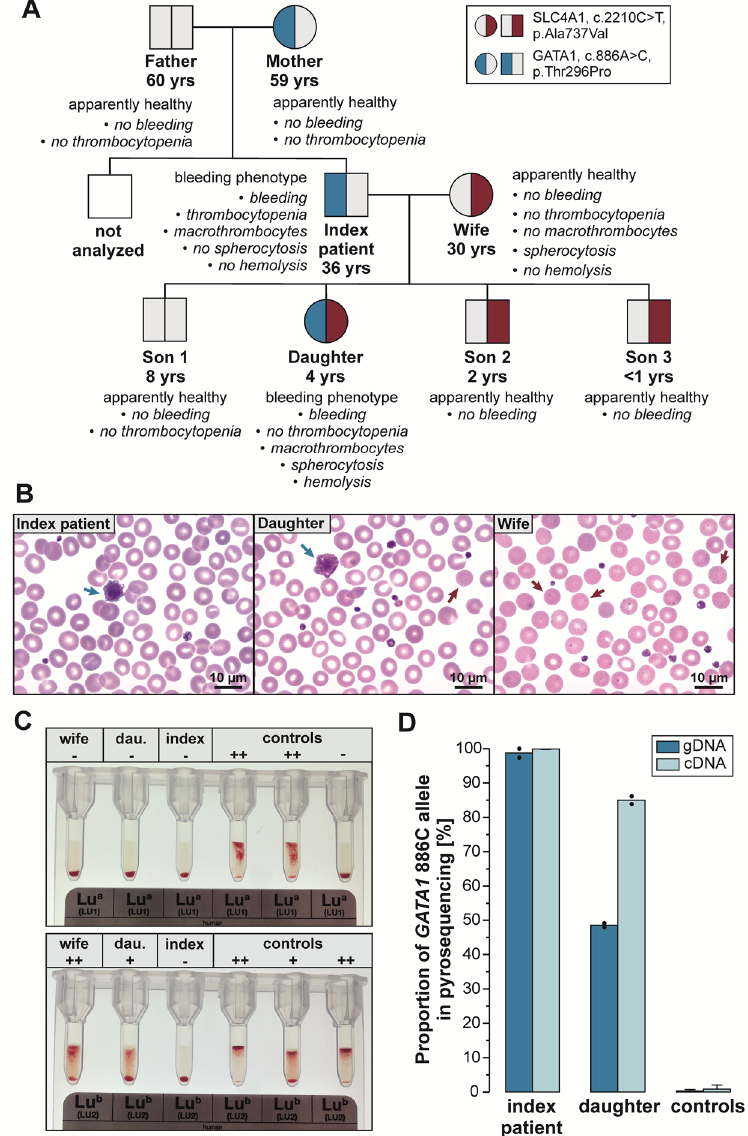
Figure 1. ( A ) Family pedigree with genotype for GATA1 : c.886A>C p.(Thr296Pro) and SLC4A1 : c.220C>T p.(Ala737Val), age at diagnosis, and individual phenotype. ( B ) Blood smear of index patient (left), his daughter (middle), and his wife (right), showing large platelets (blue arrows) and microspherocytes (exemplary, red arrows). Magnification: 100 × (oil). ( C ) Gel column agglutination assay for Lutheran blood group typing. All family members (index case, daughter (dau.), and wife) were Lu a negative (upper panel). The wife showed the highest amount of detectable Lu b (reaction strength 2+), the daughter was Lu b positive but weaker (reaction strength 1+), whereas the index patient was Lu b negative. ( D ) Analysis of X-chromosome inactivation via allele quantification of cDNA and gDNA using pyrosequencing and the pathogenic allele 886C ( GATA1 ). The index patient’s daughter showed a higher cDNA amount of the pathogenic variant than expected, revealing an imbalanced X-inactivation ( ≈ 86% variant